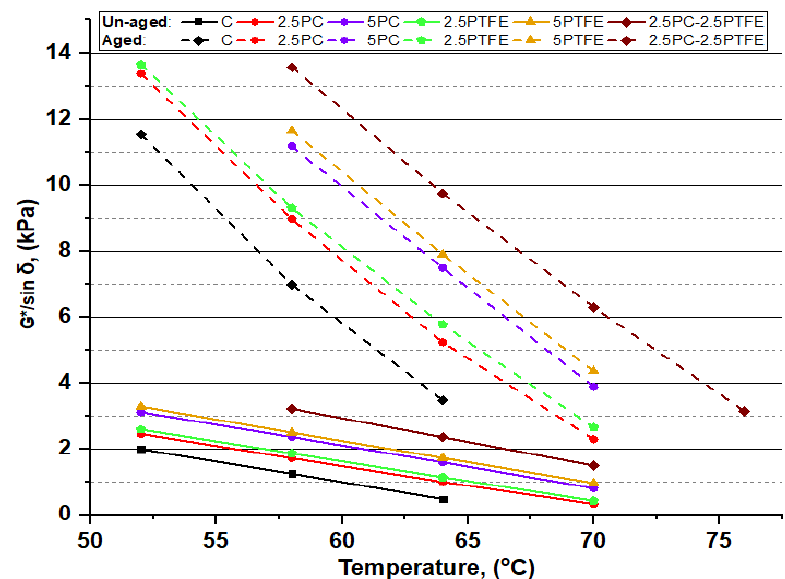
Figure 9. G*/sin δ and temperature relationship of binders before and after aging.